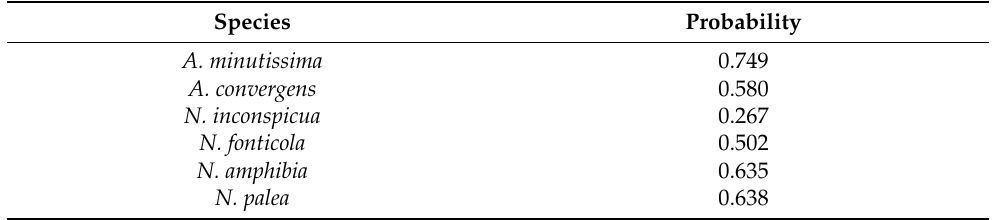
Table 4. The existence probabilities of six diatom